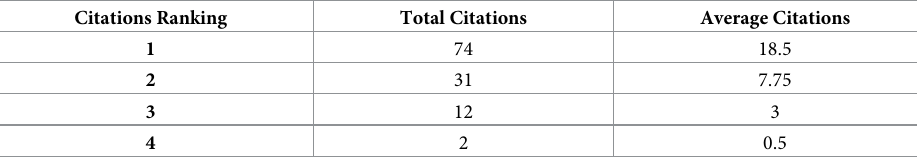
Table 3. Community citation profile (Example).